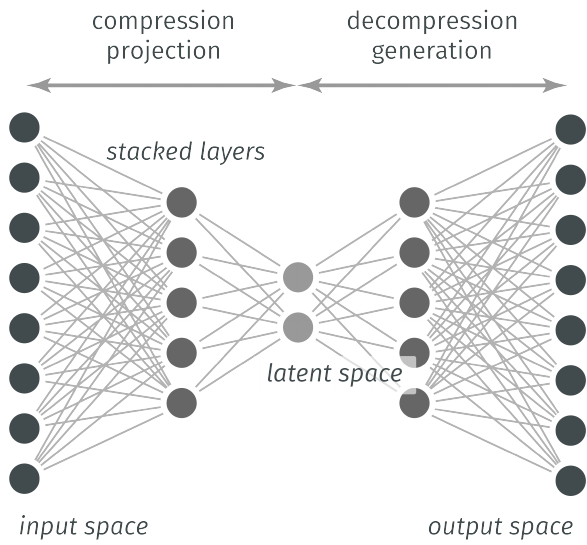
Figure 2. FCAE with multiple stacked